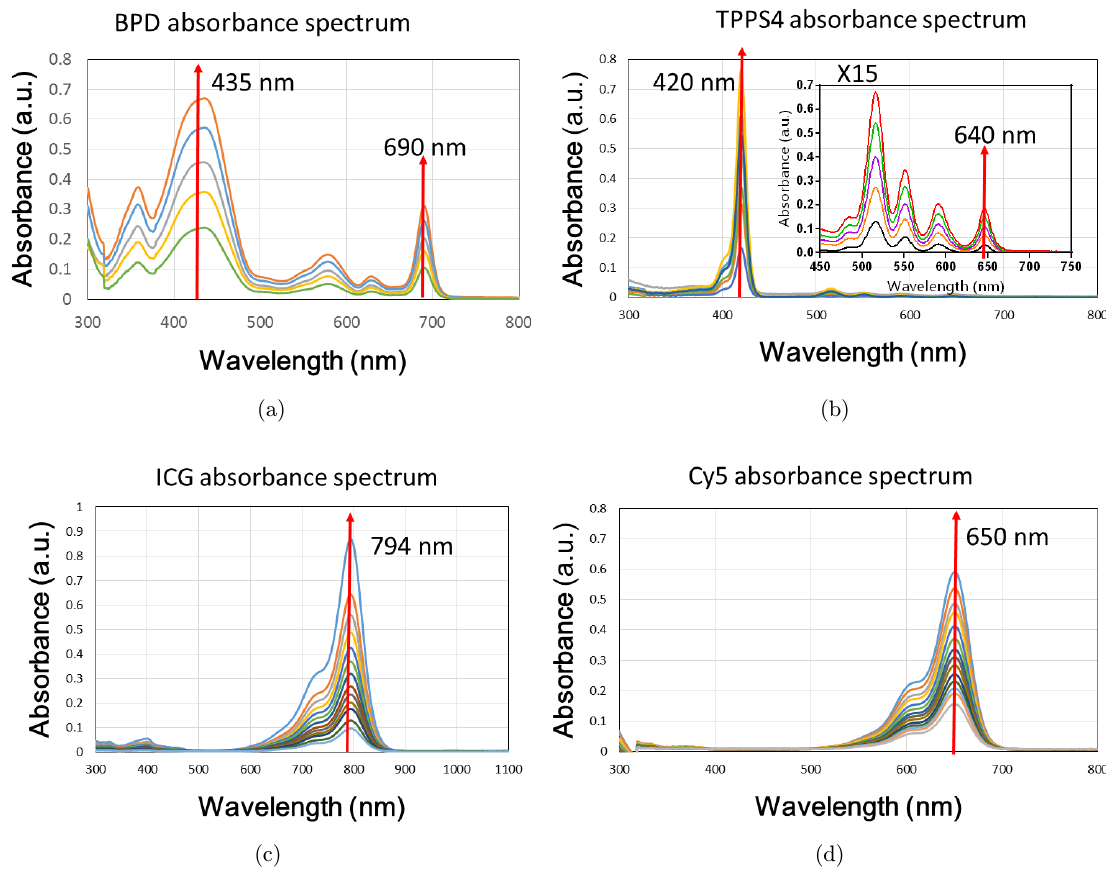
Fig. 1. Absorption spectra of (a) BPD, (b) TPPS 4 , (c) ICG and (d) Cy5 at di®erent concentration. The insert absorption spectra in (b) is a 15-fold higher concentration than the original concentration of TPPS 4 .